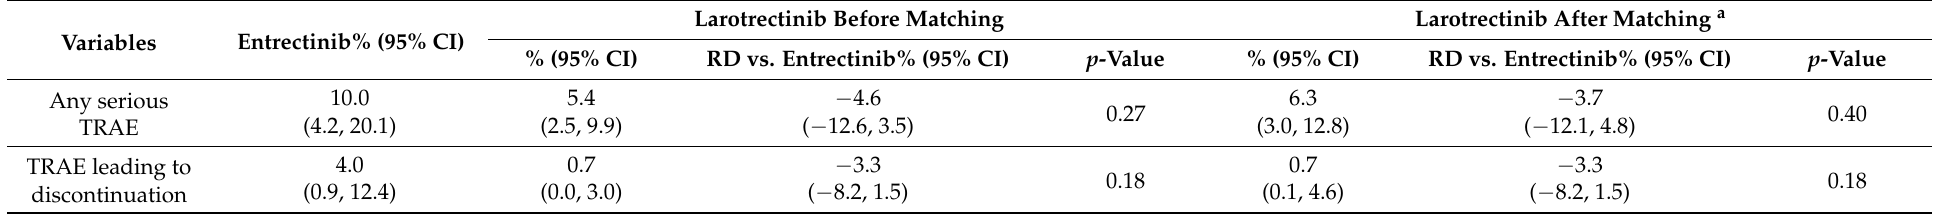
Table 4. Comparison of safety outcomes before and after matching (primary